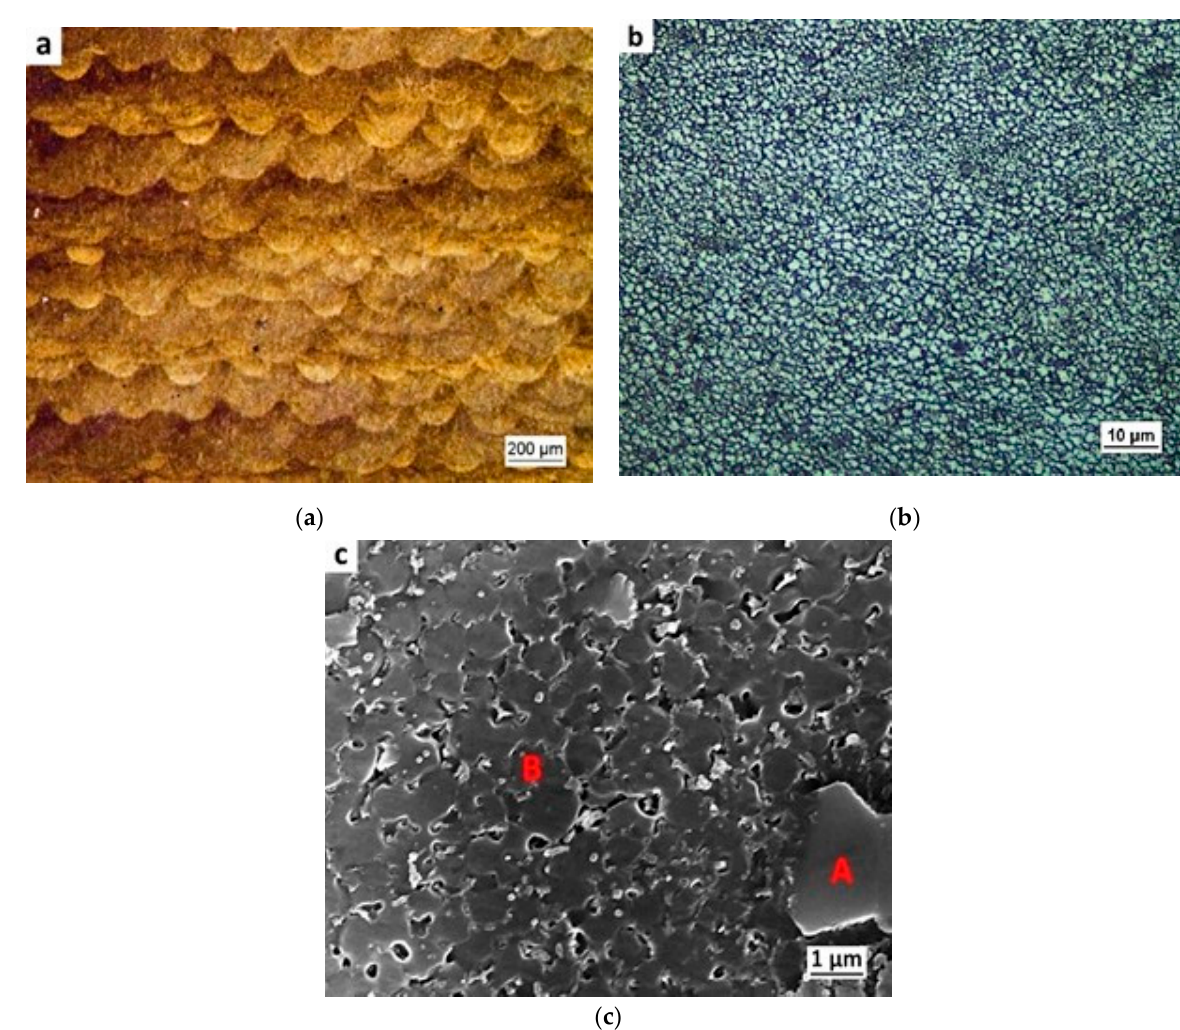
Figure 2. ( a ) Low magnification LOM image, ( b ) high magnification LOM image and ( c ) SE-SEM micrographs of the section parallel to the building direction of the as-built alloy etched in Keller’s solution.